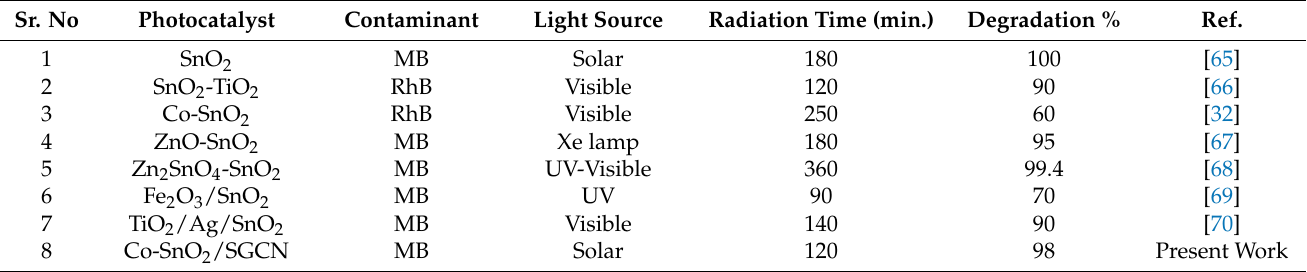
Table 4. Antibacterial activity against E. coli and B. subtilis .